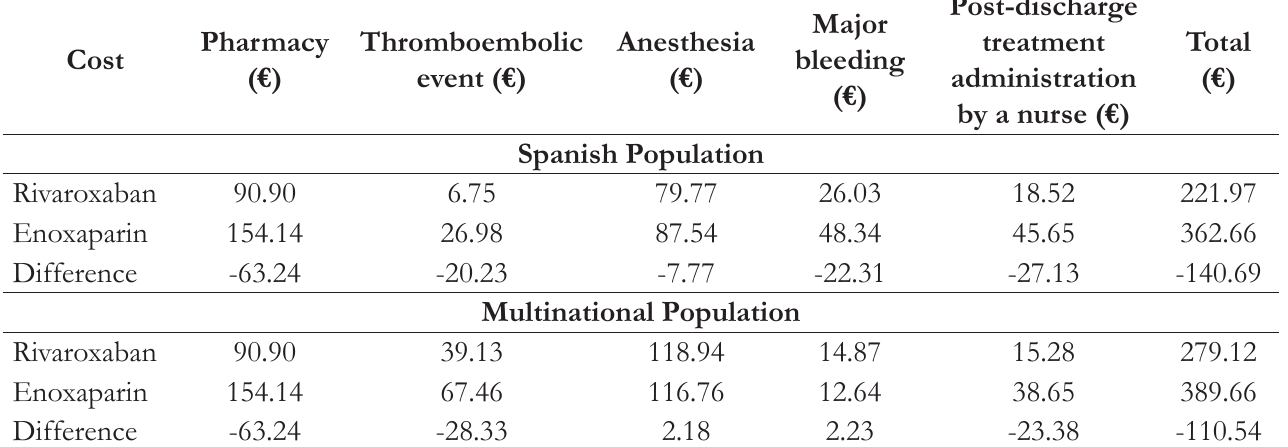
Table 4. Estimated Mean Cost per Patient Treated with either Rivaroxaban or Enoxaparin for the Prophylaxis of Thromboembolic Events after Hip or Knee Replacement Surgery in Spain using Event Rate Data from either the Spanish or the Multinational XAMOS